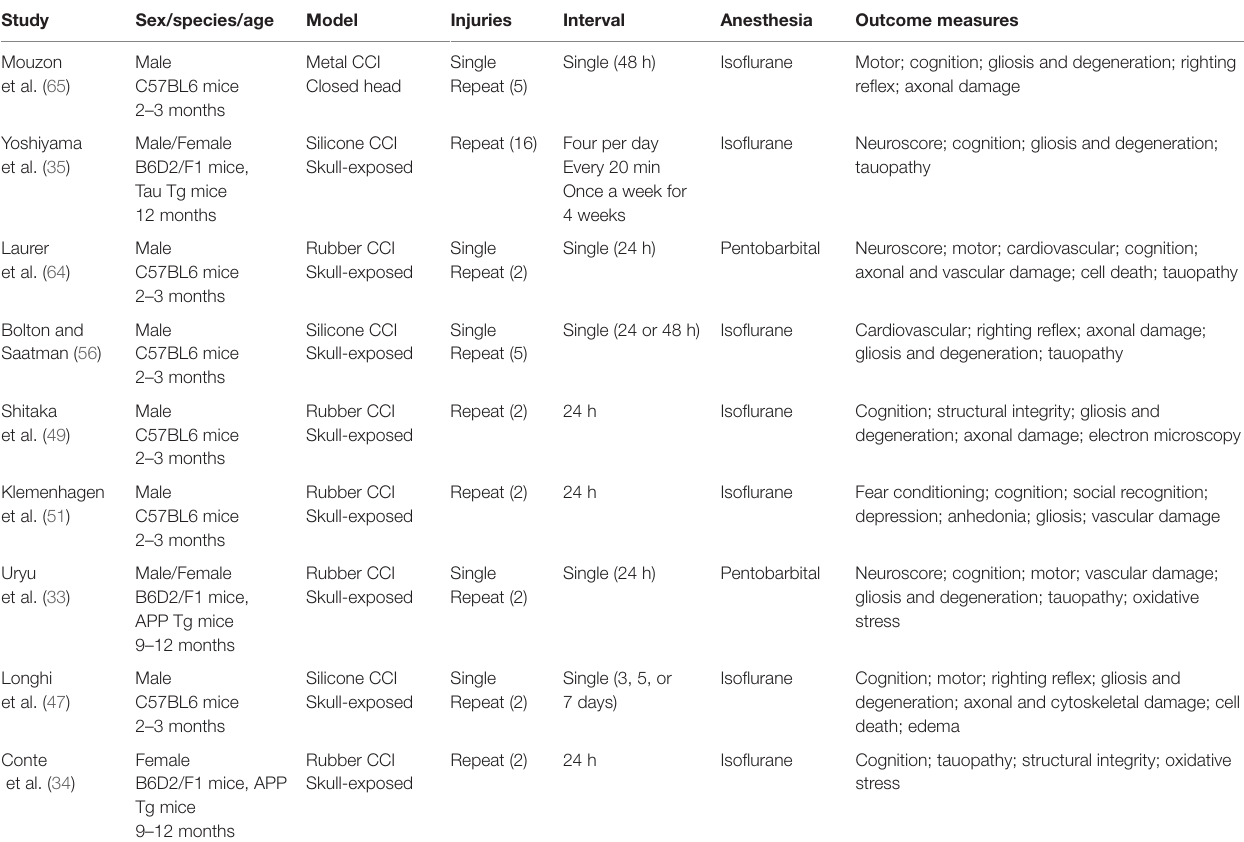
TABLe 4 | TBi models not using